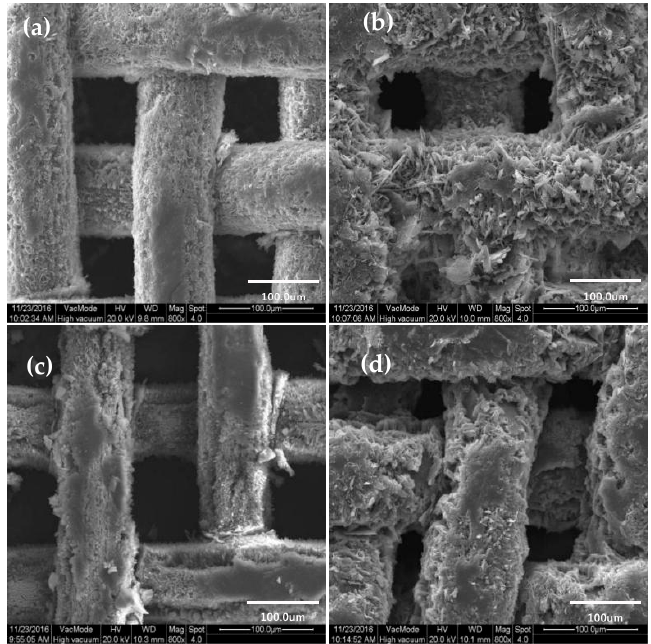
Figure 3. SEM image of copper mesh modified SA at different oxidation times. ( a ) oxidation time 0 min; ( b ) oxidation time 1 min; ( c ) oxidation time 2 min; ( d ) oxidation time 5 min.